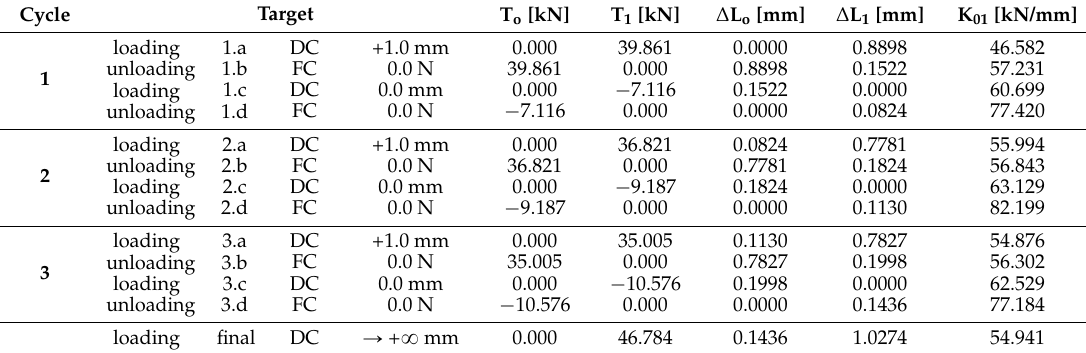
Table 8. Main test—joint sample “II”.